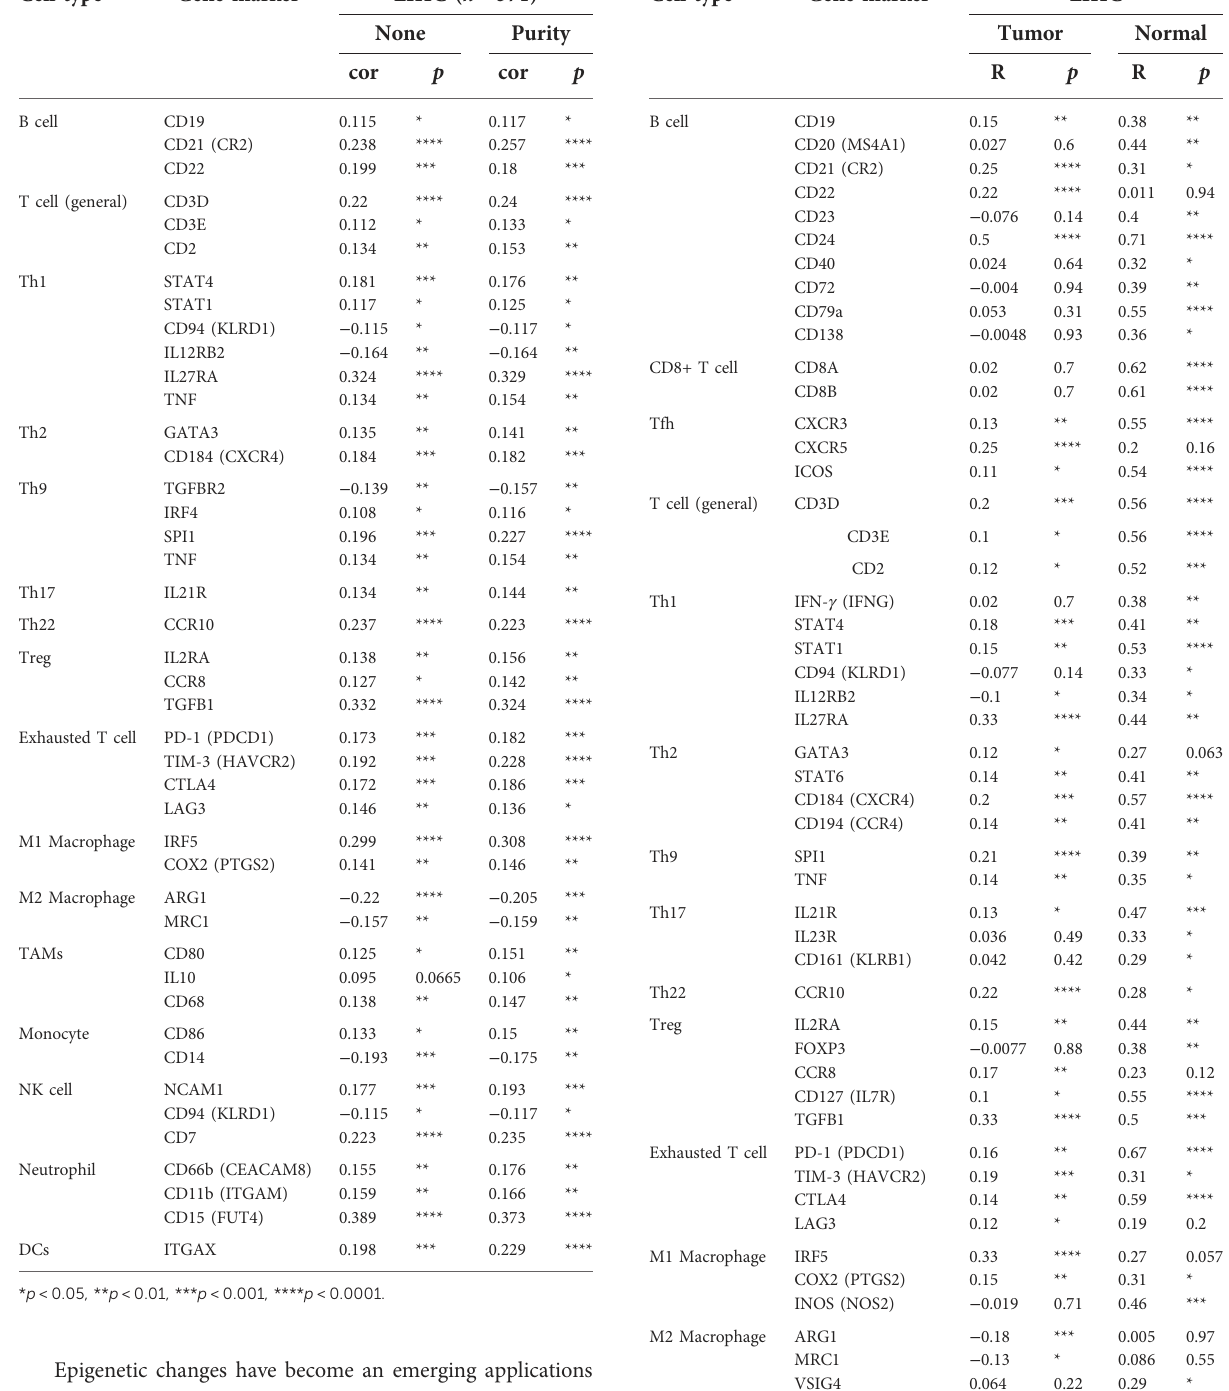
TABLE 3 Correlation analysis between BAIAP2L2 and gene markers of immune cells in TIMER (22). Cell type